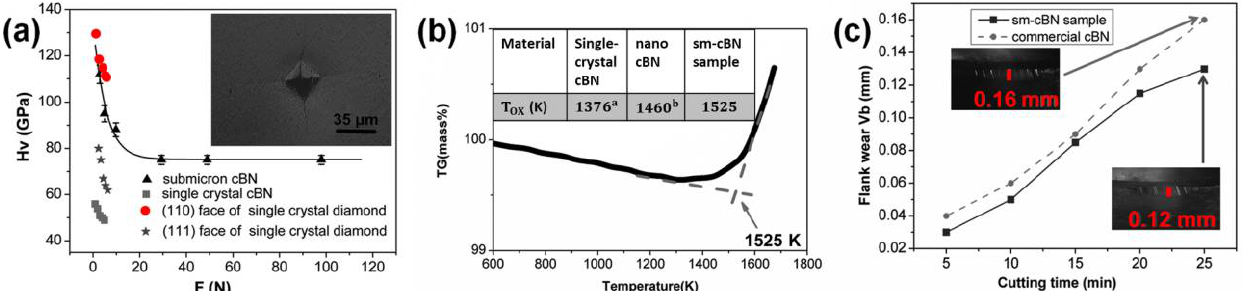
Figure 7. Properties of a sample sintered at 8 GPa and 2300 K. ( a ) Vickers hardness as a function of applied load force. Inset: an optical micrograph of the Vickers indentation with cracks produced at a load of 49 N. For single-crystal cBN, the value of Vickers hardness is ∼ 50 GPa; for the single-crystal diamond, the values of Vickers hardness are ∼ 110 GPa on the {1 1 0} face and ∼ 62 GPa on the {1 1 1} face. ( b ) The thermogravimetric curve for sm-cBN sample. Inset: table showing oxidation temperatures of different cBN samples. ( c ) The width of wear on the as-prepared sm-cBN sample and commercial cBN as functions of cutting time. Inset: photographs of the sm-cBN samples at a cutting time of 25 min. Reproduced from